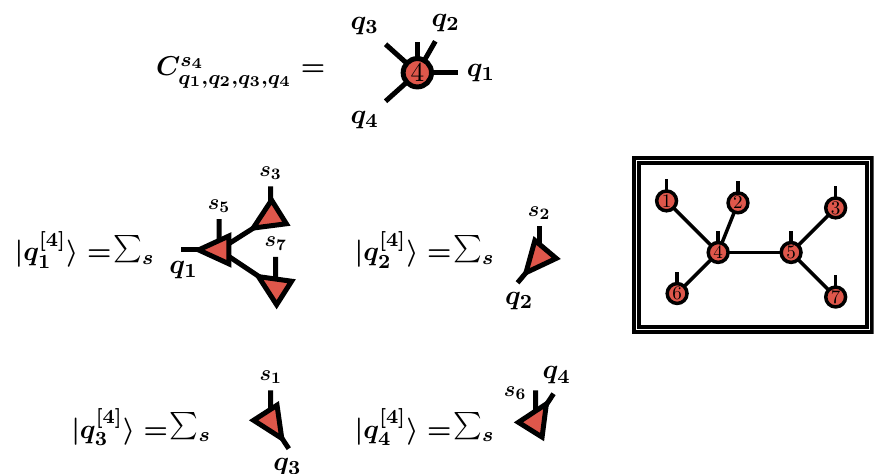
Figure 4: If the orthogonality center of the TTN depicted in Fig. 1 is placed on site 4, the center tensor C has four link indices q to one of four mutually orthogonal set of states